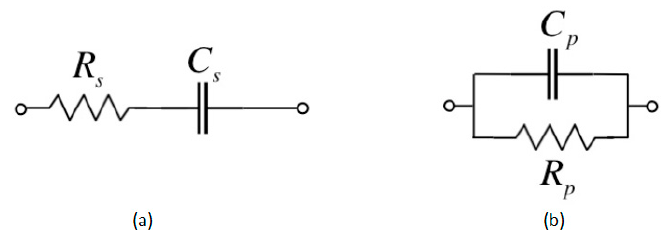
Figure 6. The equivalent circuit diagram of interdigital capacitive sensor ( a ) R S C S in series ( b ) R p C p in parallel.